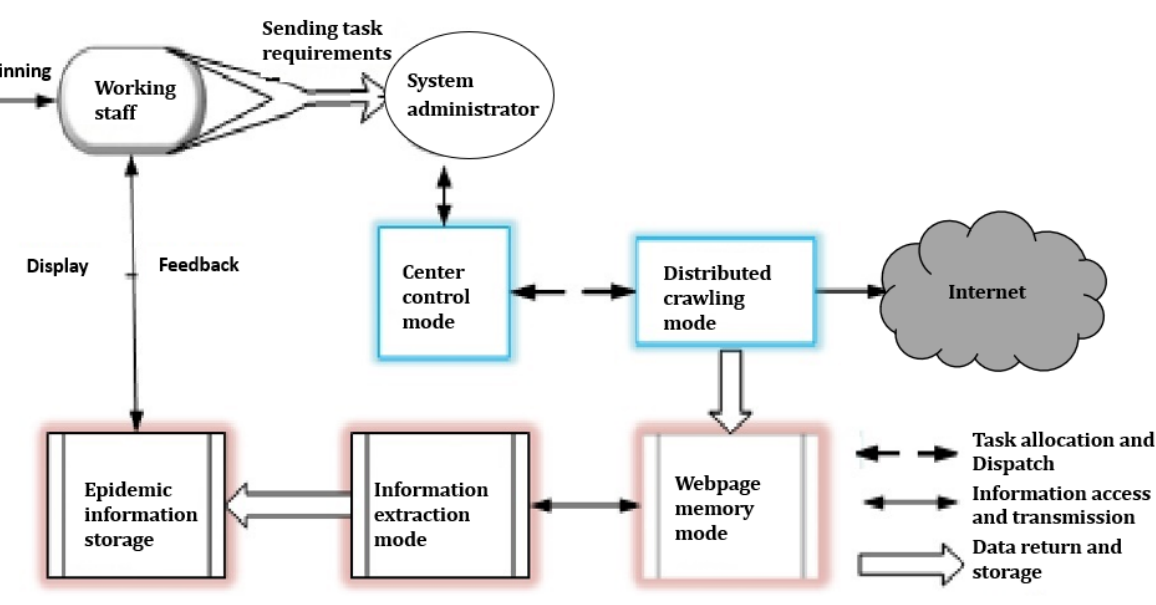
Figure 1. Principle of the Global Infectious Diseases Epidemic Information Monitoring System